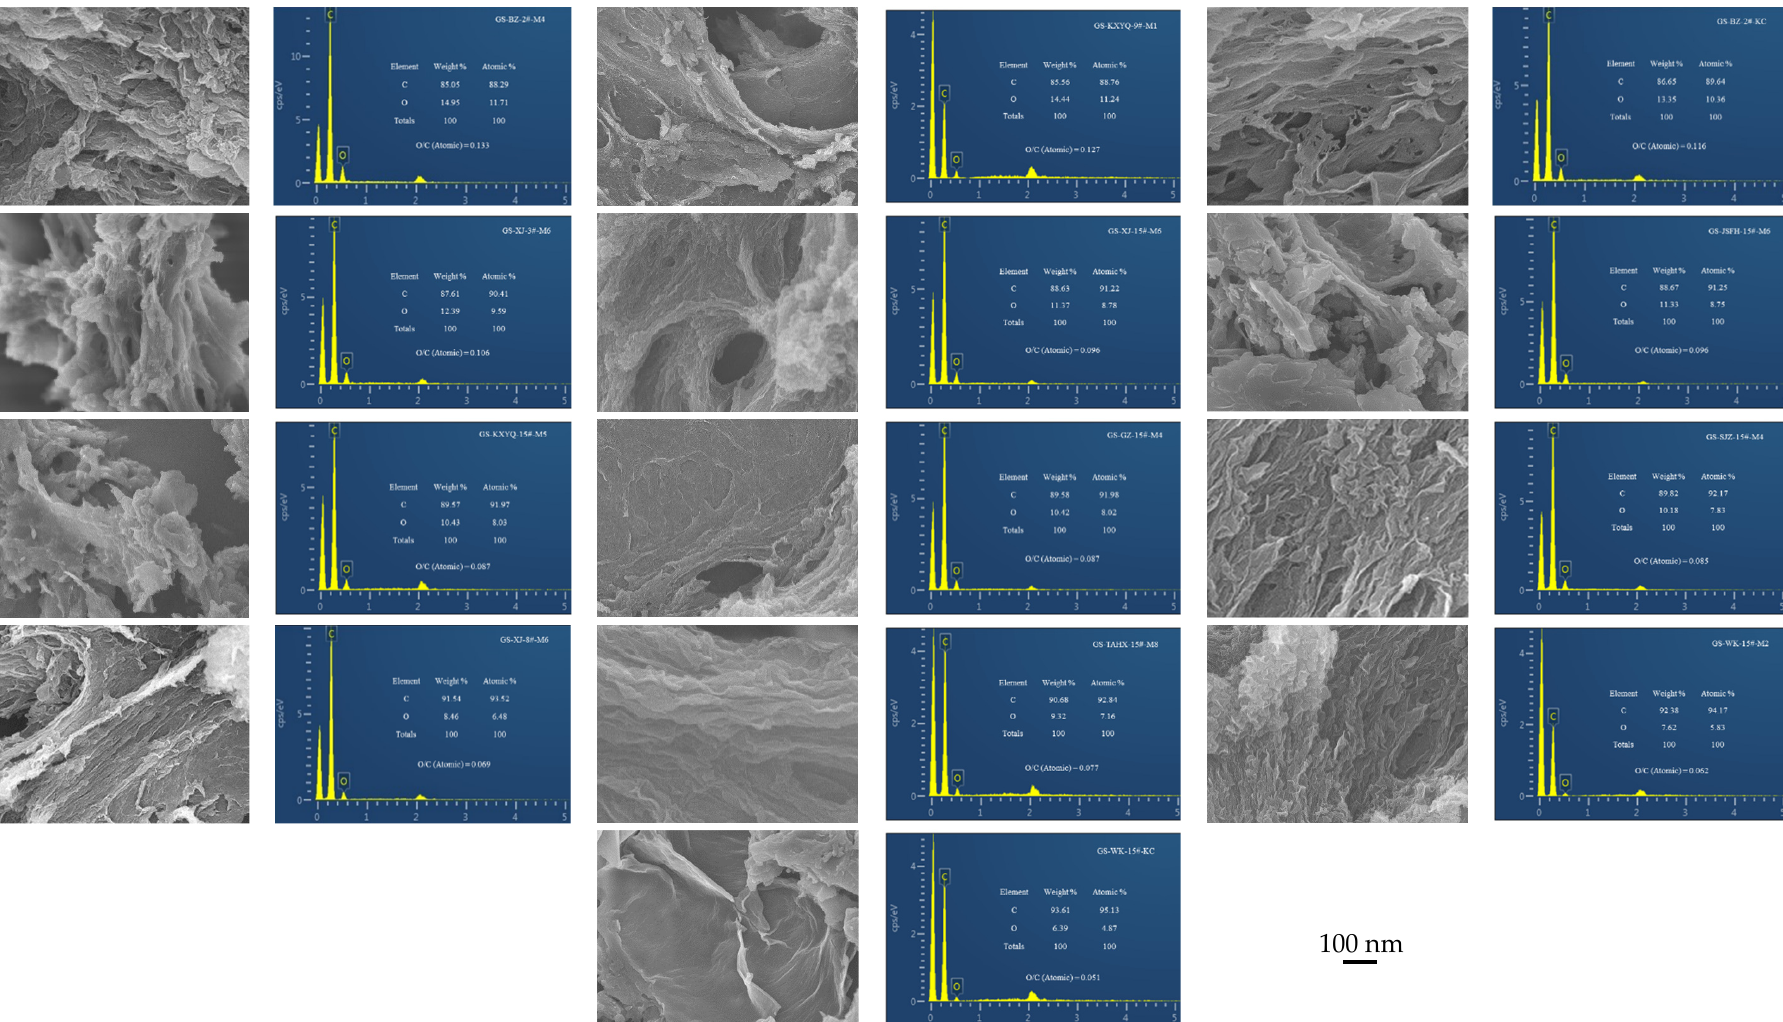
Figure 13. SEM and EDS images of coal-based graphene.